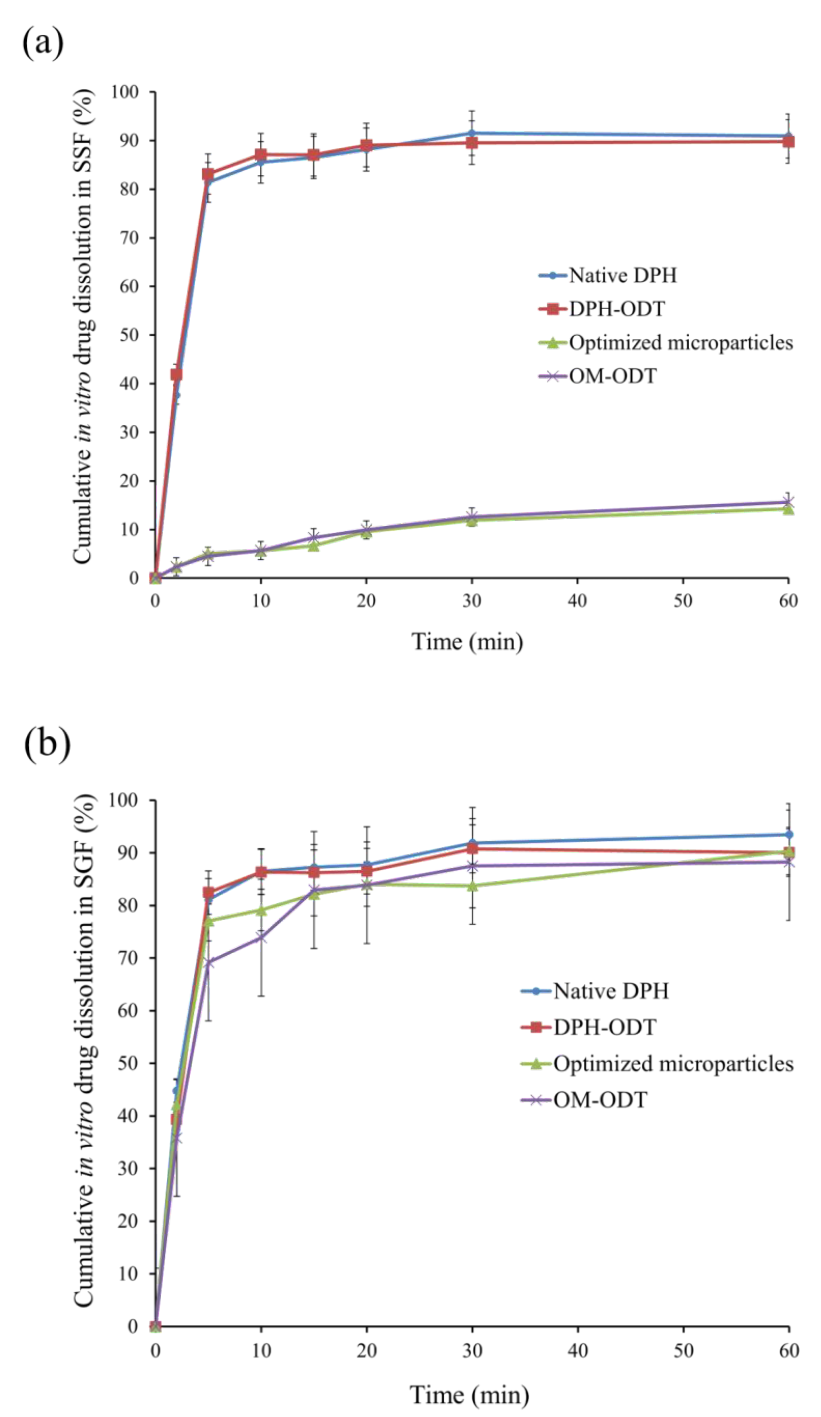
Figure 7. In vitro drug dissolution profiles of the samples in ( a ) SSF, and ( b ) SGF.